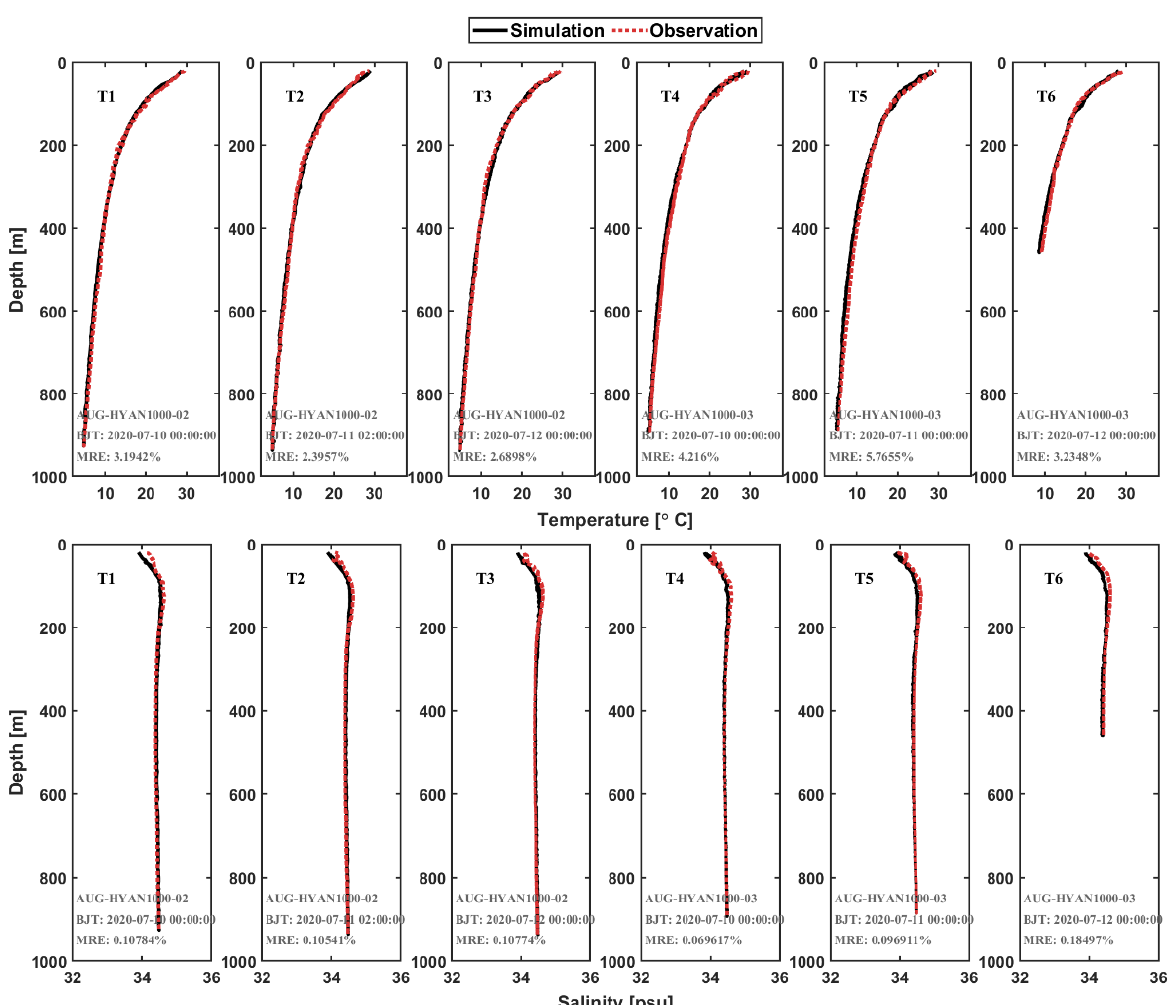
Figure 3. Model validation of temperature ( upper ) and salinity ( lower ).